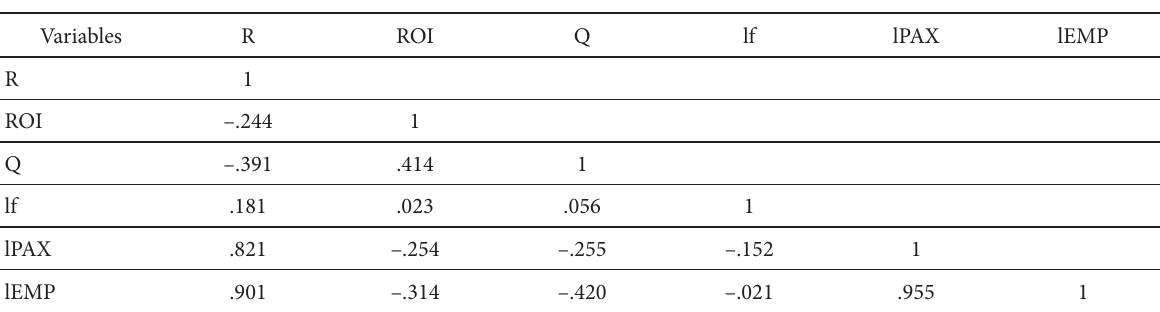
Table 3. Correlation